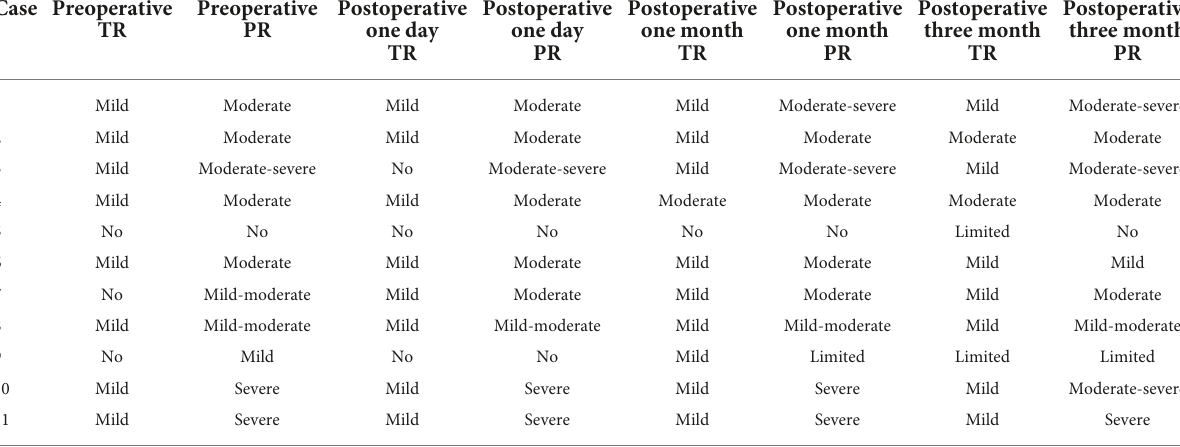
FIGURE7 Echocardiographic parameters correlated analysis. (A) : the correlation analysis of TAPSE and S’; (B) : the correlation analysis of TAPSE and LVEF; (C) : the correlation analysis of E/E (cid:48) and E (cid:48) /A (cid:48) ; (D) : the correlation analysis of RA and RVD1; (E) : the correlation analysis of RA and RVD2; (F) : the correlation analysis of RVD1 and RVD2.